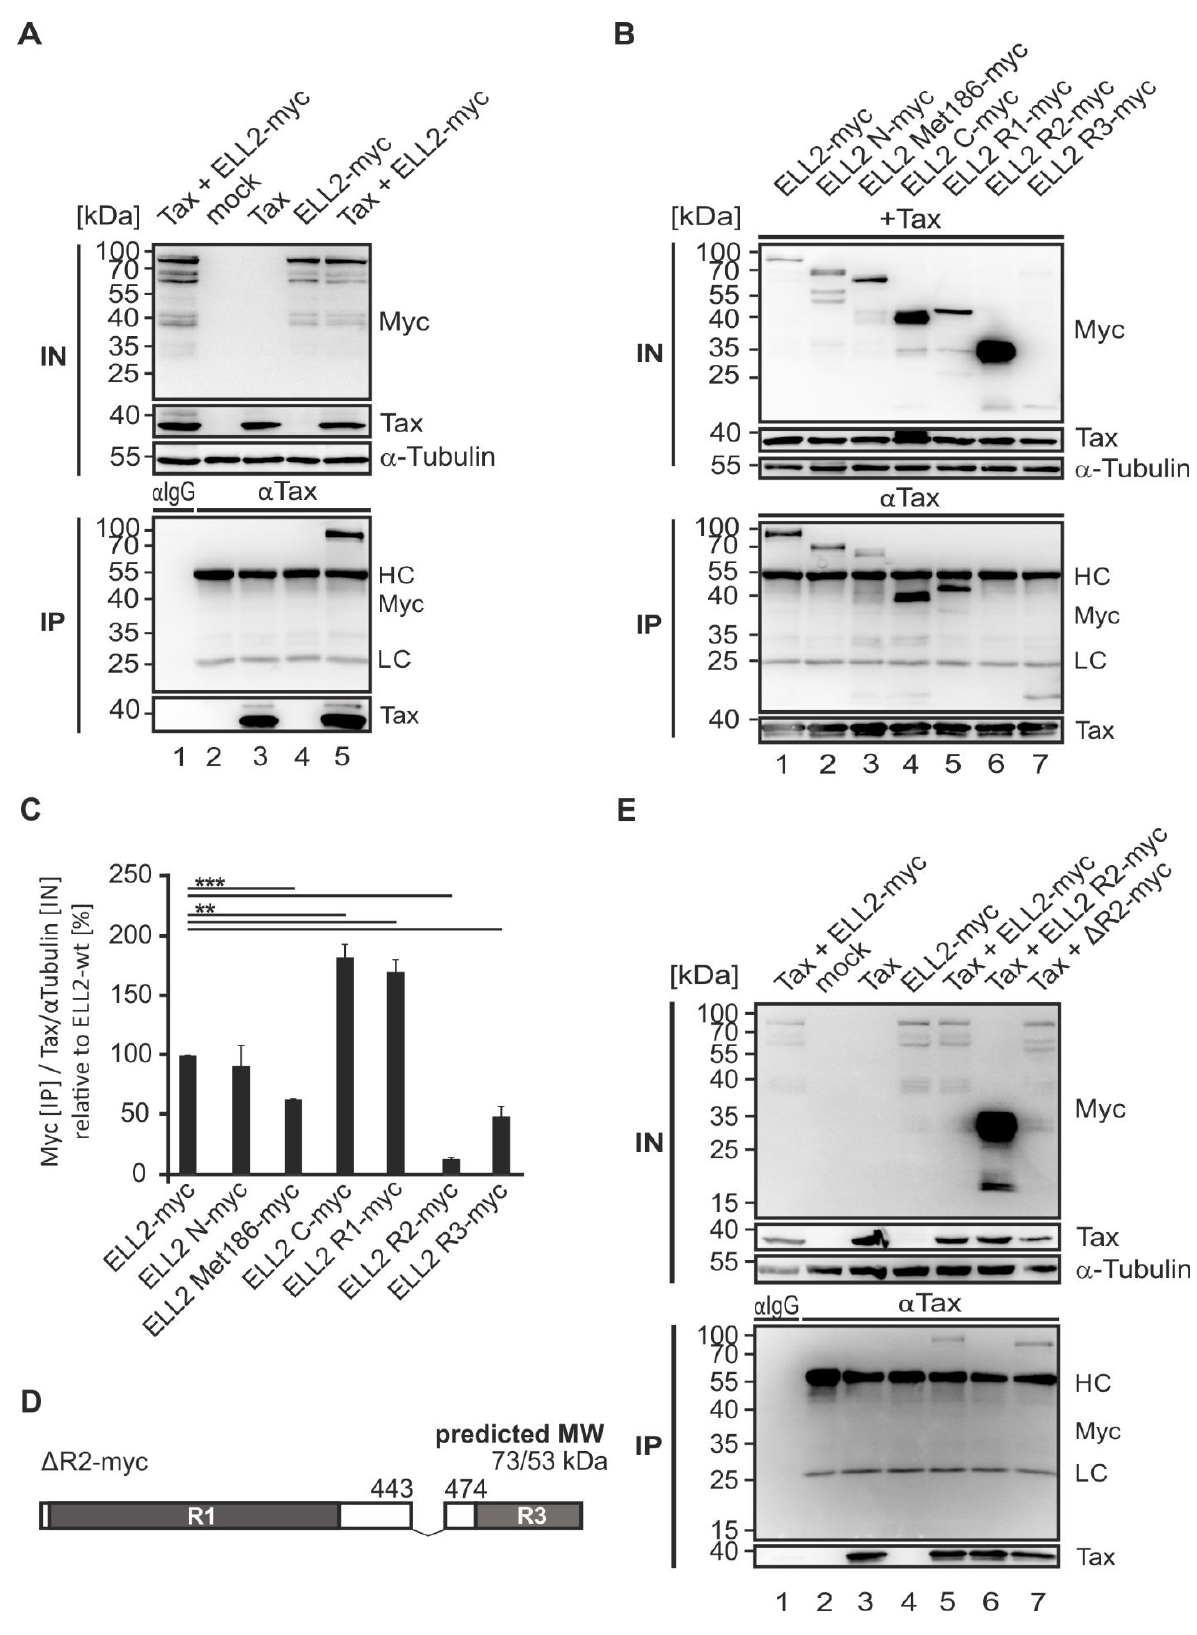
Figure 6. Multiple domains in ELL2 except ELL2-R2 are important for Tax-1:ELL2 complex formation. Co- immunoprecipitations (IP) of ( A ) Tax-1 and ELL2 and ( B ) Tax-1 and ELL2 truncations using Tax-specific precipitation antibodies. 293T cells were transfected with expression plasmids pEF-1α-Tax-1 (Tax), pEF-1α-ELL2-myc (ELL2-myc) and ELL2-truncations together with the respective empty control vector. After 48 h, cells were lysed and 10% of the lysates were taken as input (IN) control. IP was performed using anti-Tax antibodies. ( A , B ) One representative immunoblot out of five independent experiments is shown using antibodies targeting ELL2, Tax-1, and α-Tubulin. ( C ) Densitometric analysis of three independent experiments +/− SE of co-precipitated ELL2 truncations relative to Tax-1 of the input, normalized on ELL2-WT. Mean values were compared using two-tailed Student’s t -test (** indicates p < 0.01; *** p < 0.001) ( D ) Schematic representation of ΔR2-myc together with the respective predicted molecular weight (MW) values for proteins translated from the standard start codon (Met1, first value) and the alternative start codon at Met186 (second value). ( E ) Co-immunoprecipitation of Tax-1, ELL2, and ΔR2 using Tax-specific precipitation antibodies. One representative out of three independent experiments is shown. IgG, isotype control antibody; HC, heavy chain antibodies; LC, light chain antibodies. 2.7. An N-Terminal Conserved Region of ELL2, ELL2-R1, Is Crucial for Enhancing Tax-1- Mediated Transactivation of the HTLV-1 Promoter Next, we considered the ability of ELL2 truncation mutants to transactivate the viral promotor. Earlier studies have shown that ELL2 enhances Tax-1-mediated activation of the HTLV-1 promoter [33]. Hence, the analysis of the newly generated EF-1a-driven ELL2 constructs could shed light on crucial regions of ELL2 being important for supporting viral transactivation. To this end, we made use of a Tax-1-responsive luciferase-based reporter construct controlled by the U3R fragment of the HTLV-1 promoter [33,63] and performed luciferase assays in 293T cells. As expected, EF-1a-driven Tax-1 significantly increased the activity of pGL3-U3R (Figure 7A, bar 3) compared to an empty vector control (mock; Figure 7A, bar 2) or to the promotor-less pGL3-Basic luciferase vector (Figure 7A, bar 1). None of the constructs from the ELL2 mutant panel nor ELL2-WT were able to enhance the basal transactivation of the HTLV-1 promoter (Figure 7A, bars 4–11), confirming earlier findings with ELL2-WT [33]. Upon co-expression with Tax-1, ELL2-WT was able to increase the Tax-1-mediated transactivation of the HTLV-1 promotor